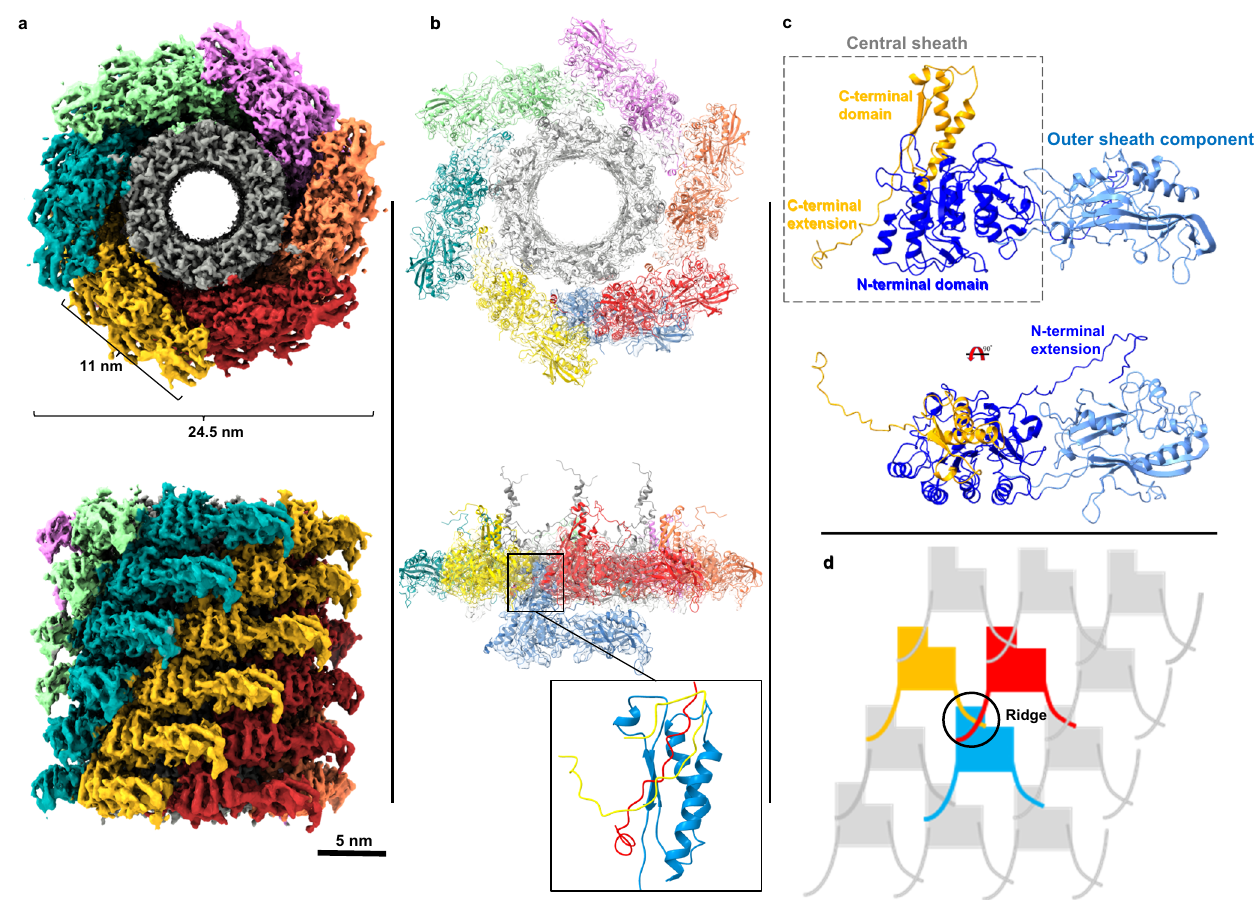
Fig. 3 | The ϕ Kp24 helical tail. a Top view (top image) and side view (bottom image)orientationsofthe3Dstructure(EMD-14357)ofthe3.0Åhelicaltail.Eachof the six helical strands is colored differently. b Model of tail sheath protein gp118 generated fromAlphafold2.Sheathproteingp118andtheinnertube-proteingp119 were fi tted into one ring of the ϕ Kp24 EM map (upper image, top view; lower image, side view). In the bottom panel, the sheath monomer (blue) that originates from the lower layer is shown to allow visualization of the ring-ring interactions. Contacts between three sheath monomers are highlighted from two successive